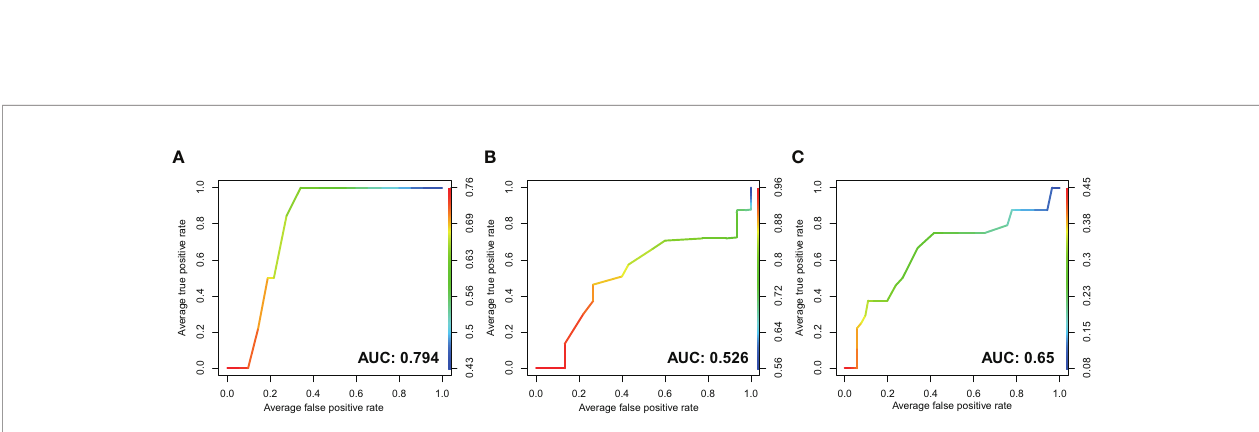
FIGURE 5 | The performance of GI microbiota in prediction of PLGC by receiver operating characteristic (ROC) curve analysis. The discriminatory potential of the mucosal microbial model in (A) H. pylori -positive subjects and (B) H. pylori -negative subjects. (C) The discriminatory potential of the microbial model in stool samples.